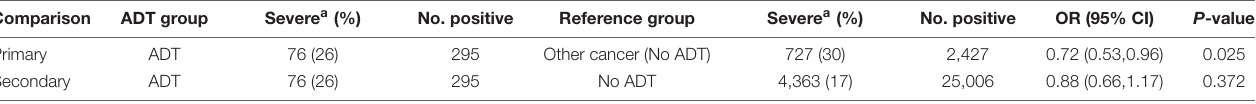
TABLE 4 | Association between ADT use and COVID-19 severity.